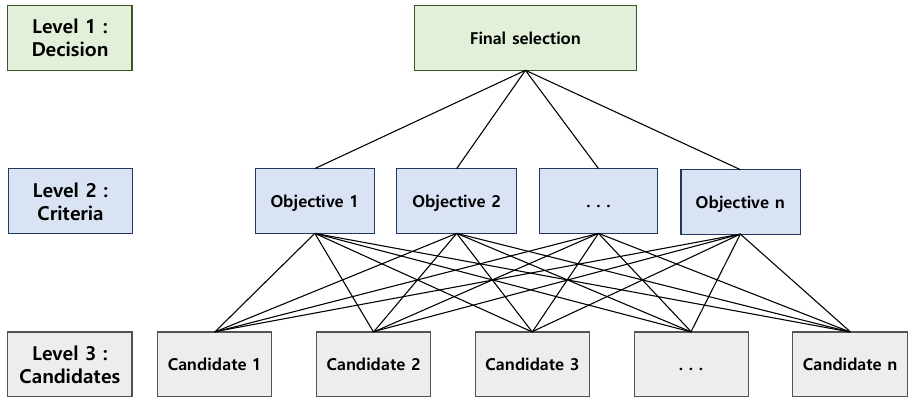
Figure 3. AHP decision making structure.